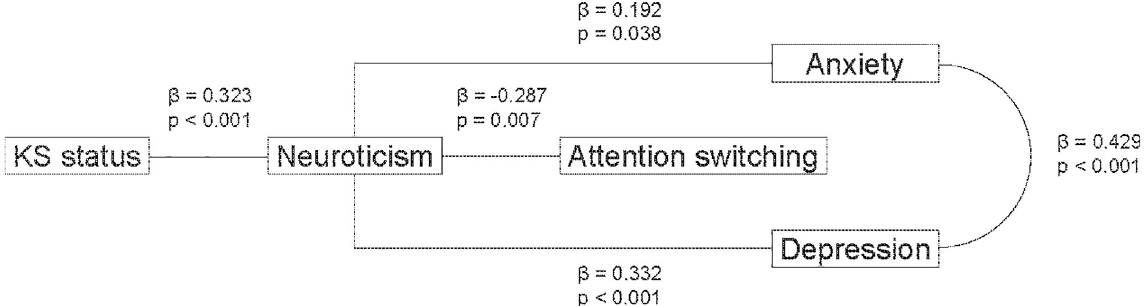
Fig 1. Path models of memory anxiety and depression with β standard coefficients and